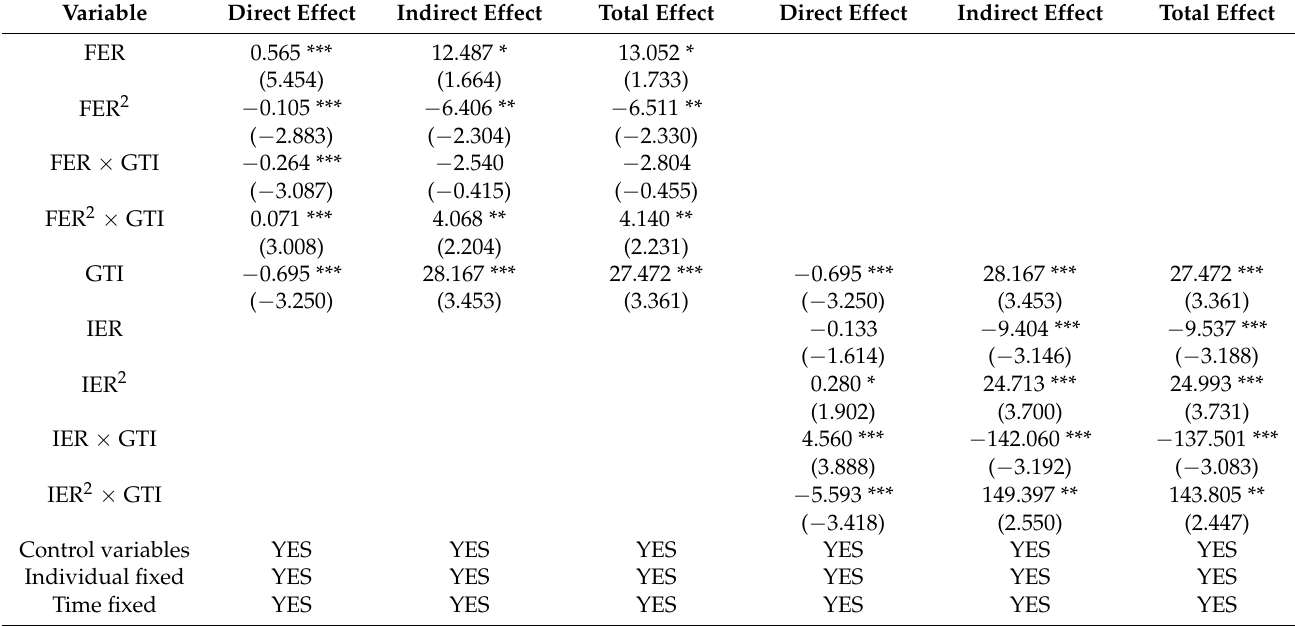
Table 9. Analysis of the moderating effect of green-technology